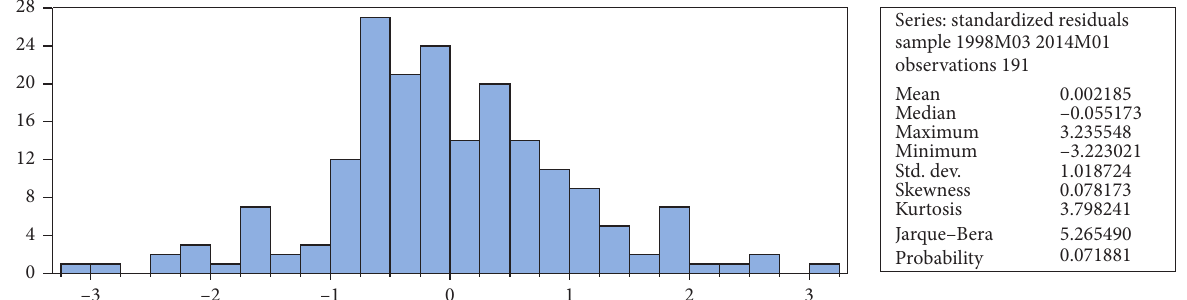
Figure 3: Histogram of standardized residuals for the test of normality of residuals from the fitted model for price of silver series.